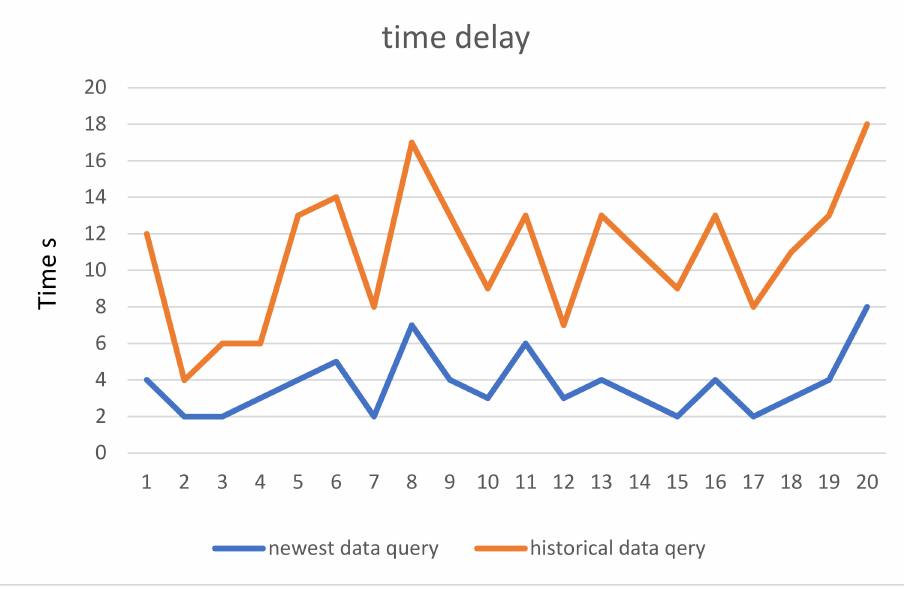
Figure 18. The delay time of newest and historical data query (2400 clients’